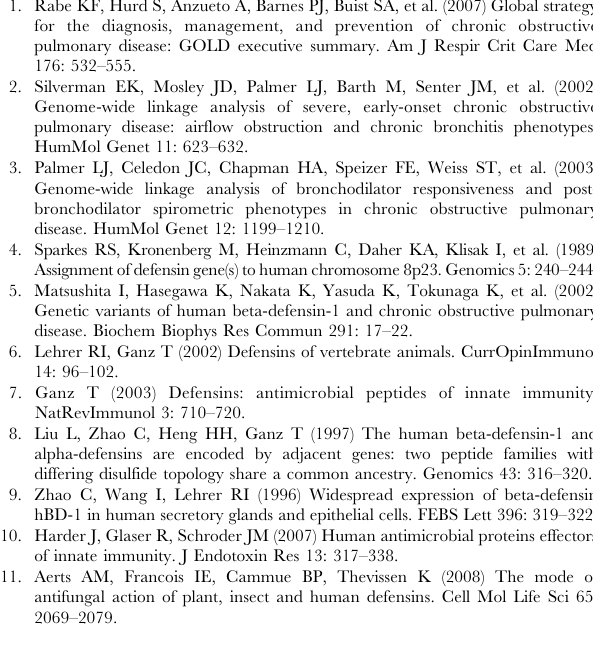
Figure S1 DEFB4 mRNA expression in bronchial epithe- lial cell biopsies from patients with COPD and healthy controls. Expression levels of DEFB4 mRNA in epithelial cell biopsies from patients with COPD (N=34 total, N=13 for COPD